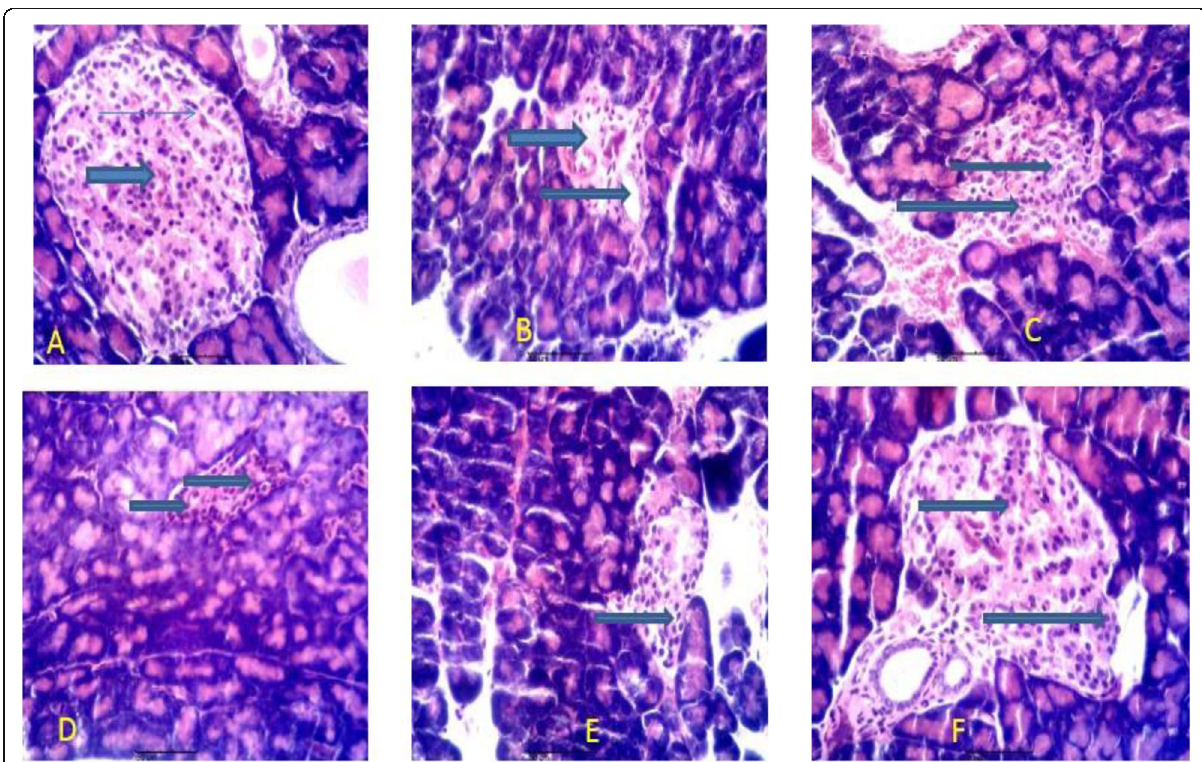
Fig. 2 Photomicrograph of pancreas of: A = Group A rats (Normal control) showing well populated islet cells (arrows); B = Group B rats (Diabetic untreated) showing severely depleted islet cells. Arrows show areas devoid of cells. C = Group C rats (Diabetic + 200 mg/kg of Vermonia amygdalina) s howing evidence of adequately populated islet cells (arrows). D = Group D rats (Diabetic + 200 mg/kg of Vermonia amygdalina ) showing relatively moderate population of islet (arrows). F = Group F rats (Diabetic + 2 mg/kg glibenclamide) showing well populated islet cells (arrows). H&Ex